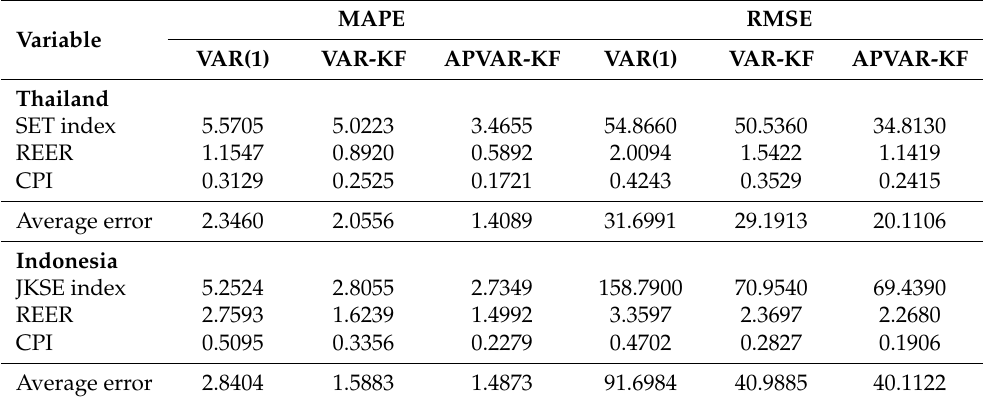
Table 4. Mean absolute percentage errors and root mean square errors during the training phase